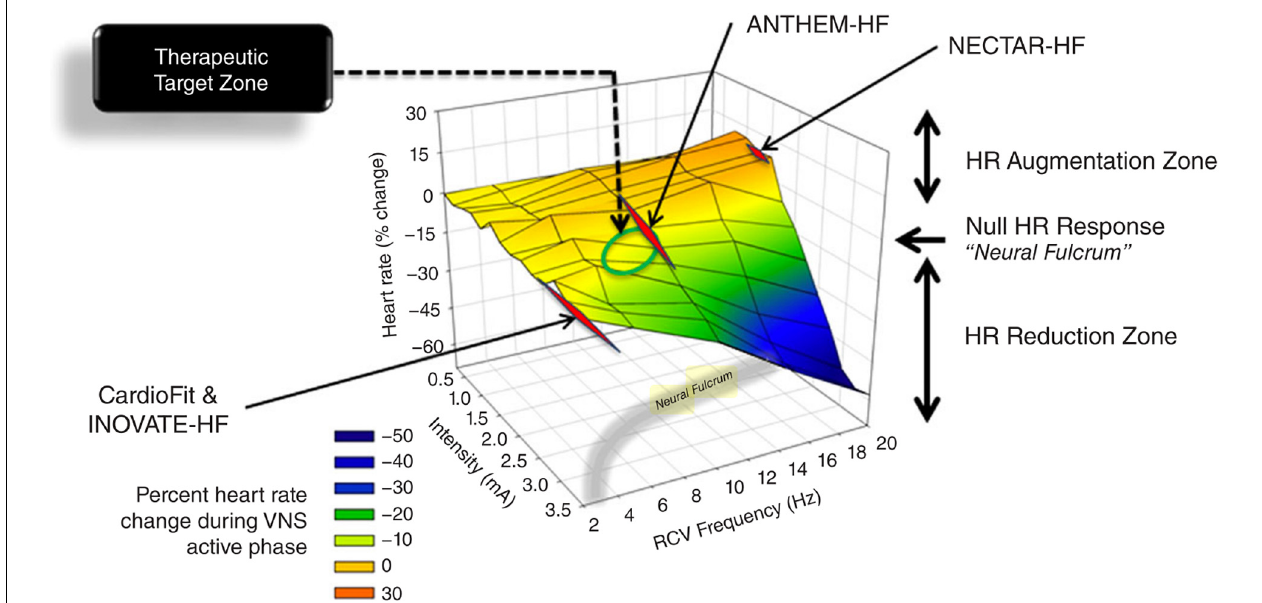
FIGURE 4 | 3D plot of percent change in heart rate against right VNS intensity and frequency, with representation of the neural fulcrum in the yellow-shaded region. Operational points used in the NECTAR-HF, INOVATE-HF, and the ANTHEM-HF studies. Adapted from Ardell et al. (17).